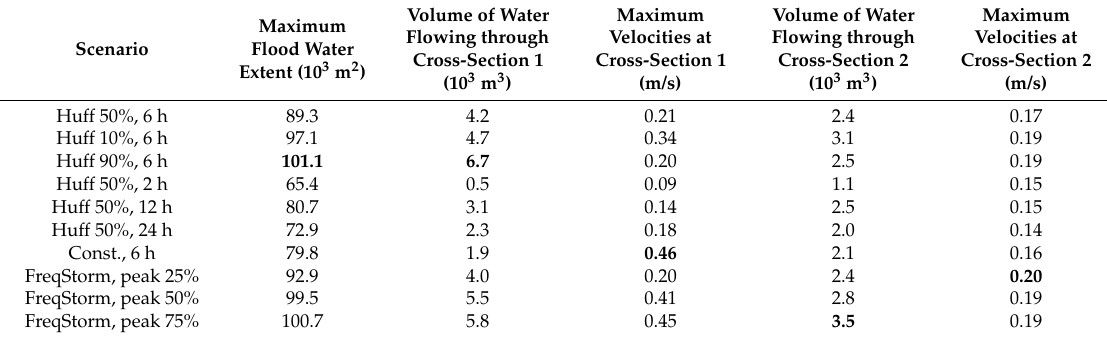
Table 3. Comparison among maximum floodplain extents, maximum floodplain velocities, and floodplain volumes for 10 selected scenarios for the 10-year return period. Bold values indicate maximum values in each column.